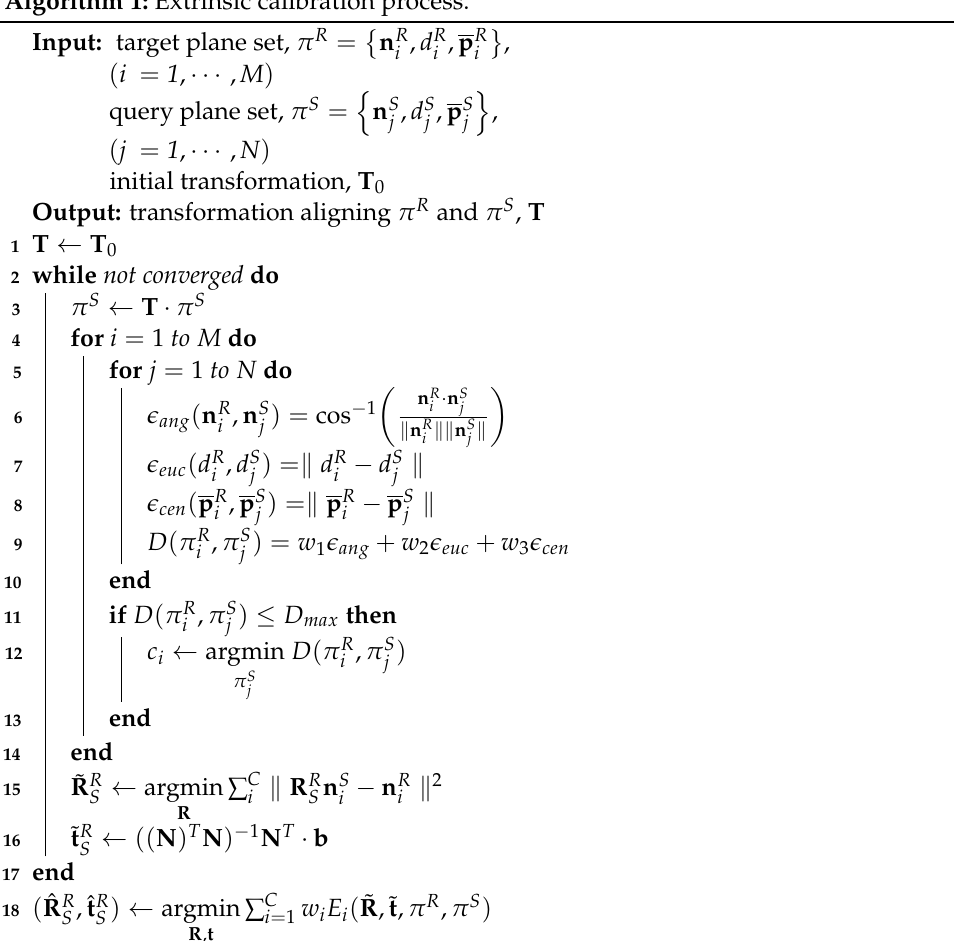
Algorithm 1: Extrinsic calibration